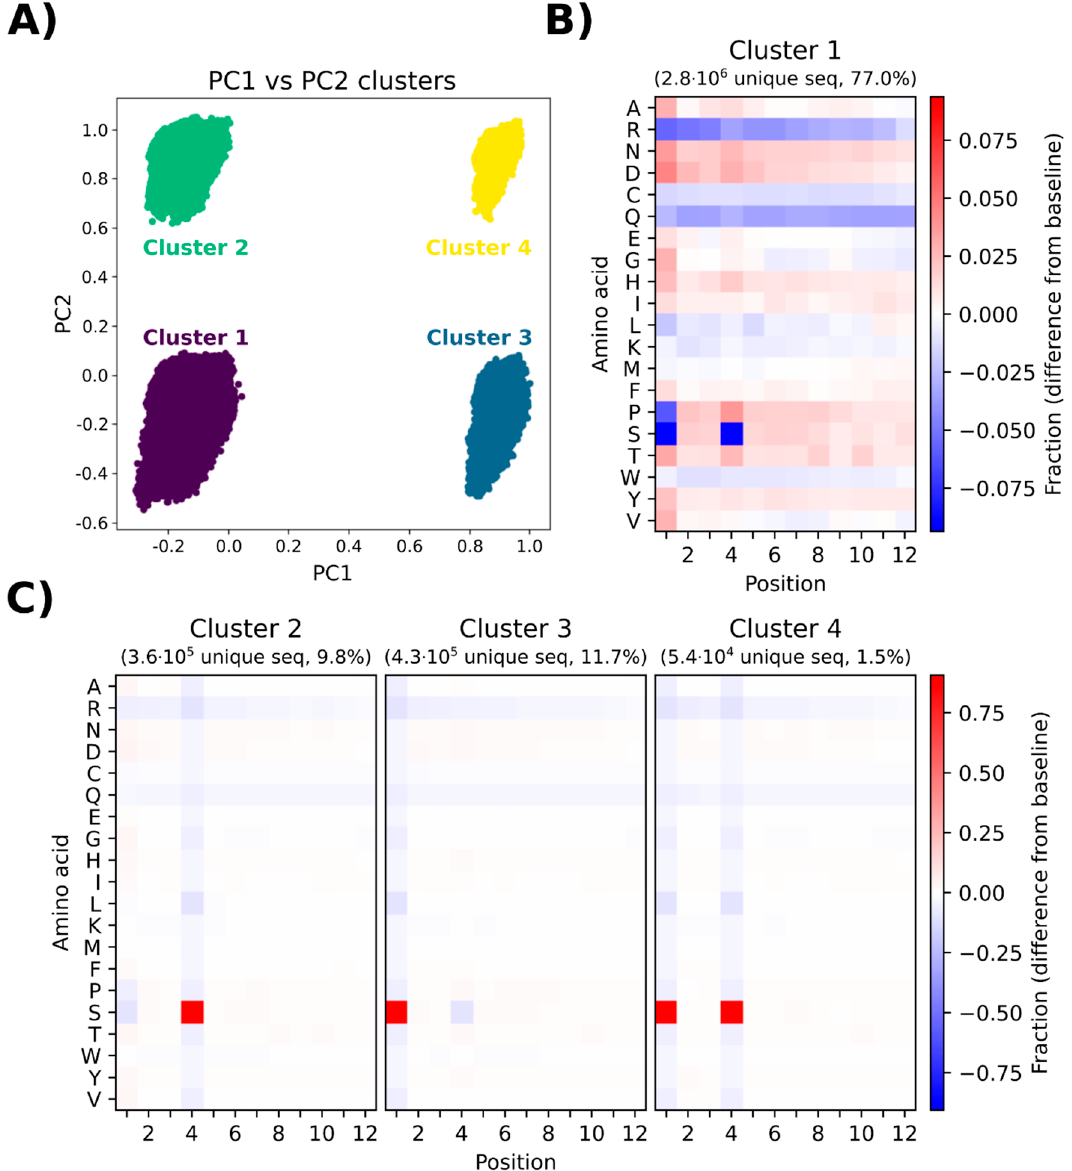
Figure 5. ( A ) PCA plot (PC1 and PC2) of the naïve library showing four clusters in the pool of sequences. ( B ) Heatmap showing overrepresentation (red) or underrepresentation (blue) compared to the expected value of each amino acid for each position according to the expected value for cluster 1. ( C ) Heatmap showing overrepresentation (red) or underrepresentation (blue) compared to the expected value of each amino acid for each position according to the expected value for cluster 2, cluster 3, and cluster 4.